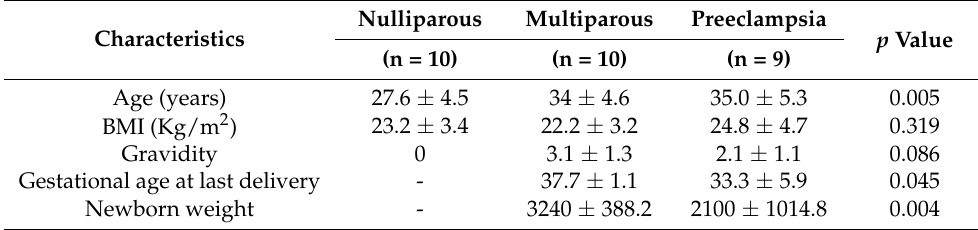
Table 1. Characteristics of controls and preeclampsia donors.